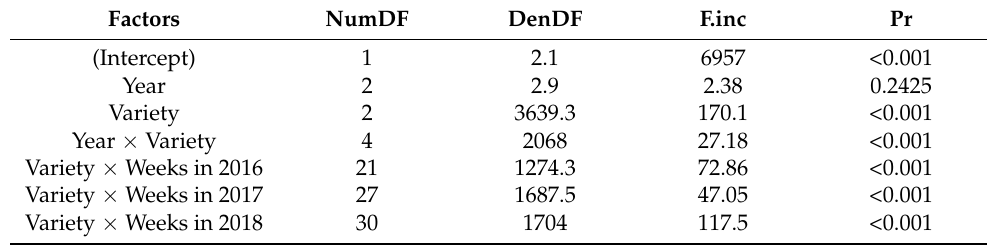
Table 1. The repeated measures ANOVA examining the effect of variety and year and the